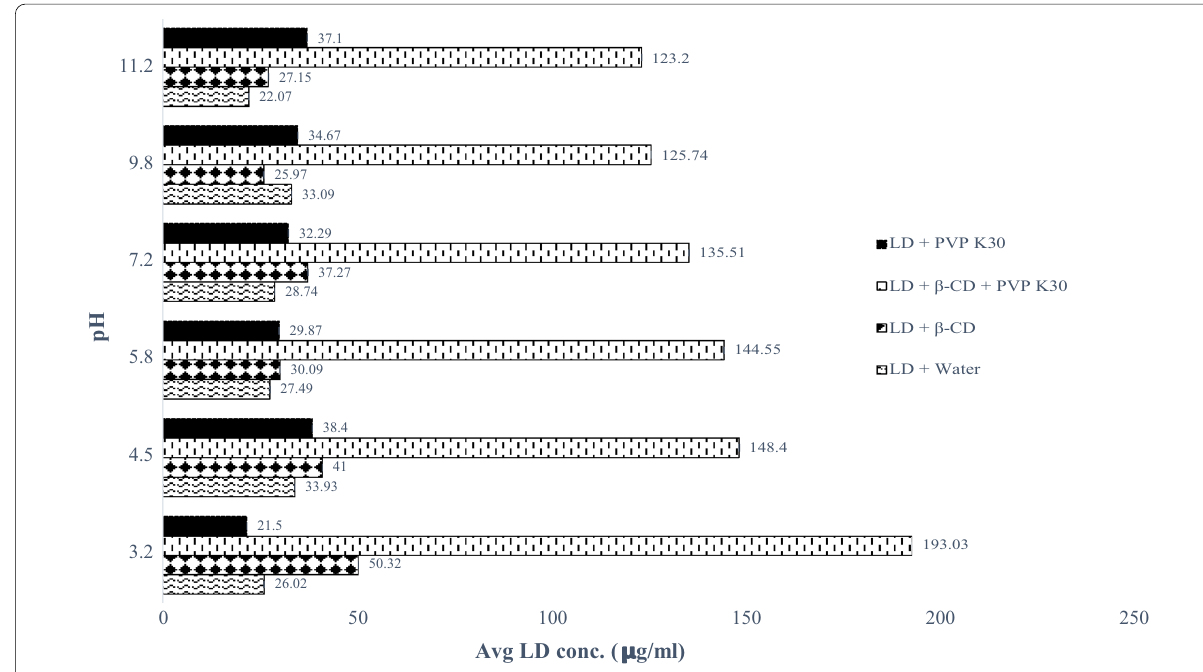
Fig. 4 Effect of pH on solubility of LD in presence/absence of polymer and co-polymer